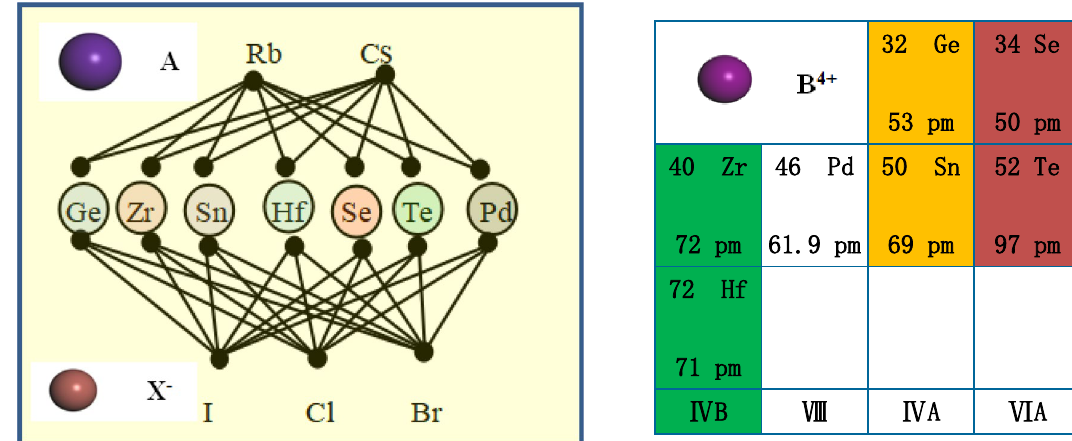
Figure 2. ( a ) High-throughput screening methods for network chain structure diagram and ( b ) properties of important elements germanium (Ge), selenium (Se), zirconium (Zr), palladium (Pd), tin (Sn), hafnium (Hf), tellurium (Te).